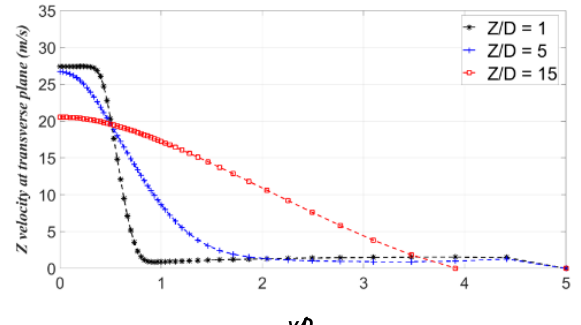
Figure 10. Axial velocity variation perpendicular to centerline planes at different streamwise locations.